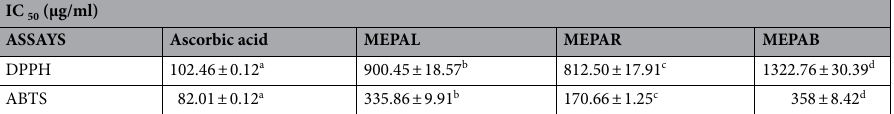
Table 3. IC 50 value for the scavenging activity of ABTS and DPPH by P. americana extracts. Values represent mean ± standard deviation of replicate readings. Where MEPAL methanol extract of P. americana leave, MEPAR methanol extract of P. americana root, MEPAB methanol extract of P. americana stem bark. Values with different superscripts (a,b,c,d) along the same row are significantly different from one another (P < 0.05).